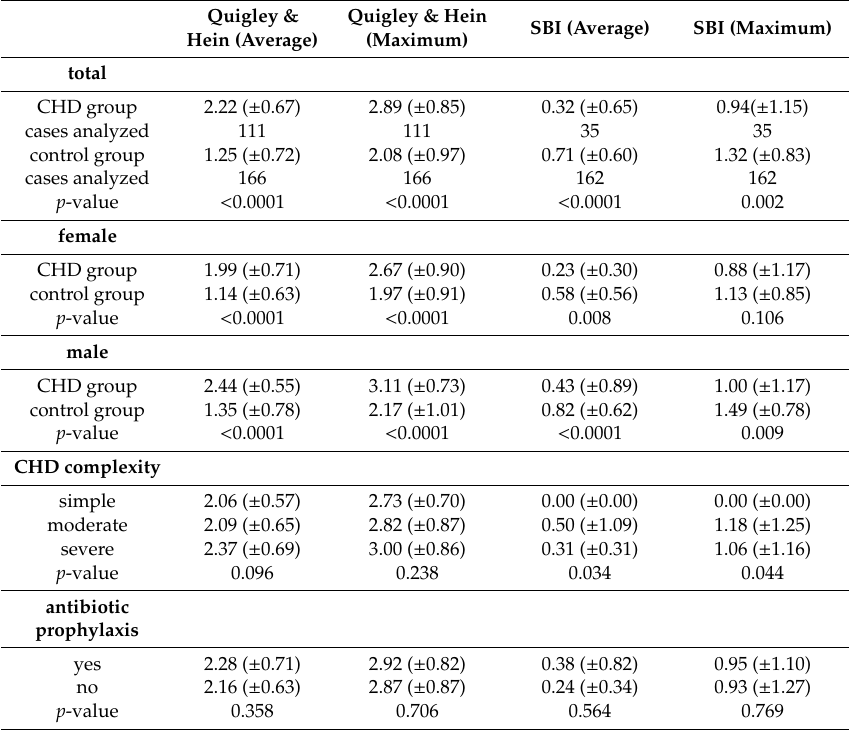
Table 6. Oral health parameters among patients with congenital heart disease and healthy control subjects. Analysis of di ff erences between groups has been done with Mann–Whitney test, analysis between subgroups (CHD complexity) with Kruskal-Wallis test.